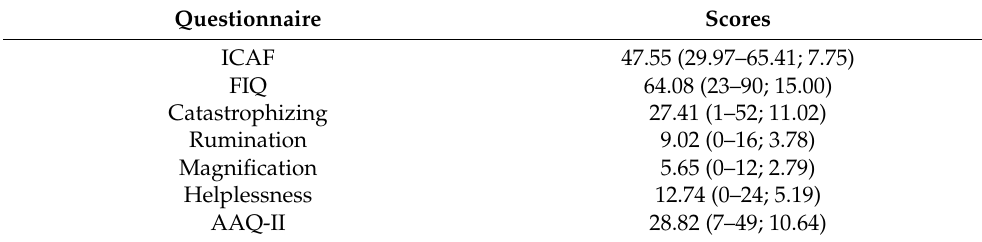
Table 2. Mean score (range; SD) ( N = 187).